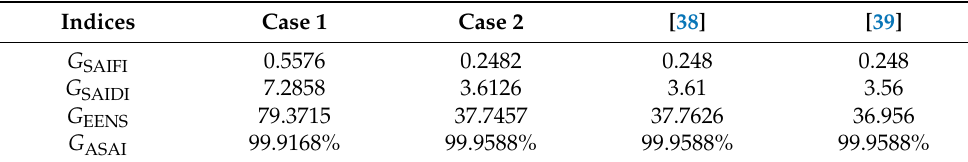
Table 3. Comparison of reliability indices